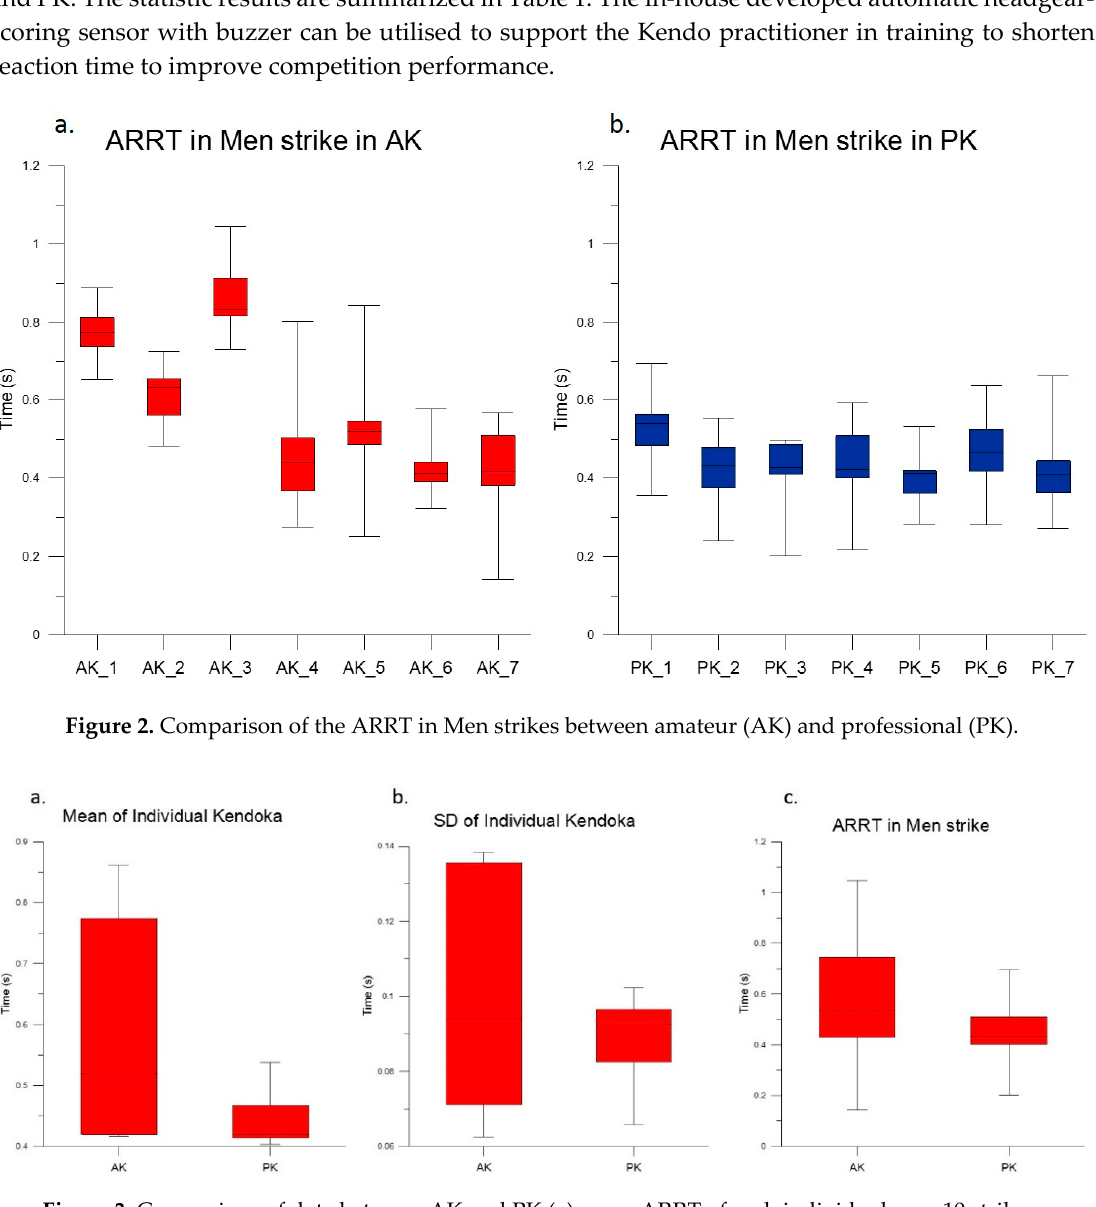
Figure 3. Comparison of data between AK and PK ( a ) mean ARRT of each individual over 10 strikes; ( b ) SD of ARRT of each individual over 10 strikes; ( c ) ARRT for all recorded strikes. Table 1. The statistic for ARRT between PK and